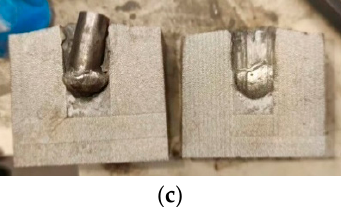
Figure 5. Perforation and morphology. ( a ) Perforation of the target. ( b ) Morphology of the F target. ( c ) Morphology of the projectile and the witness target.